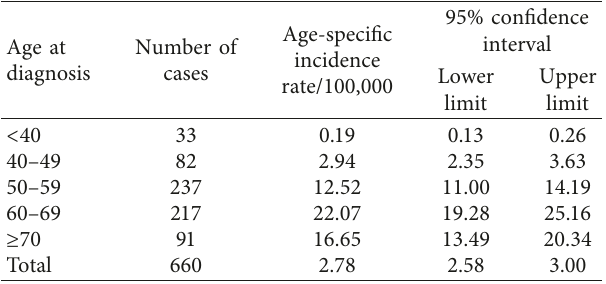
Table 2: Age-specific incidence rate (per 100,000) of 660 uterine cancer diagnosed in the Gharbiah population of